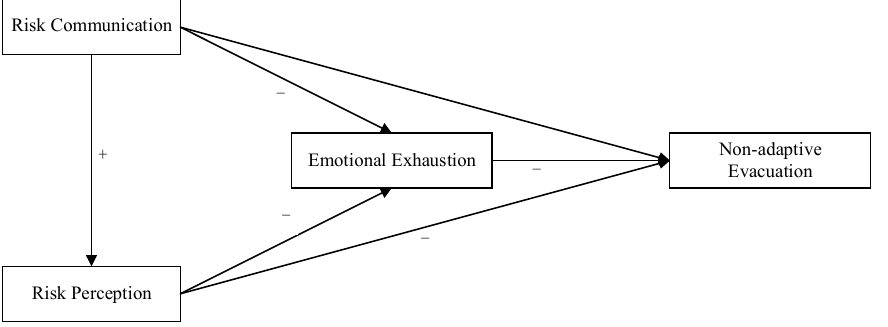
Figure 1. Conceptual model. “+” means there is a positive relationship. “ − ” means that there is a negative relationship.